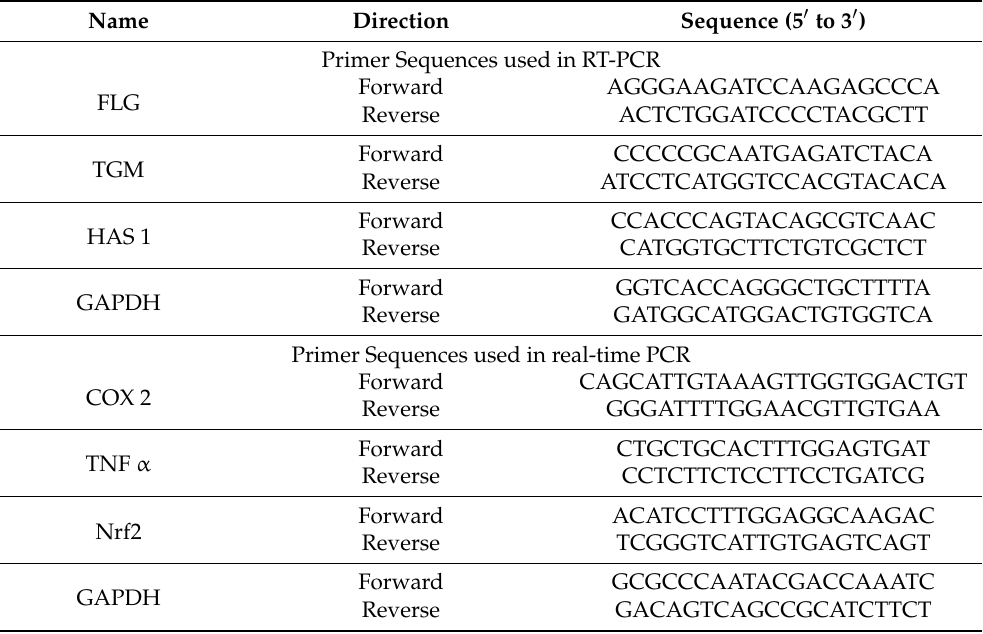
Table 1. Primer sequences for the analysis of mRNA prepared for RT-PCR and real-time PCR. Name Direction Sequence (5 (cid:48) to 3 (cid:48)